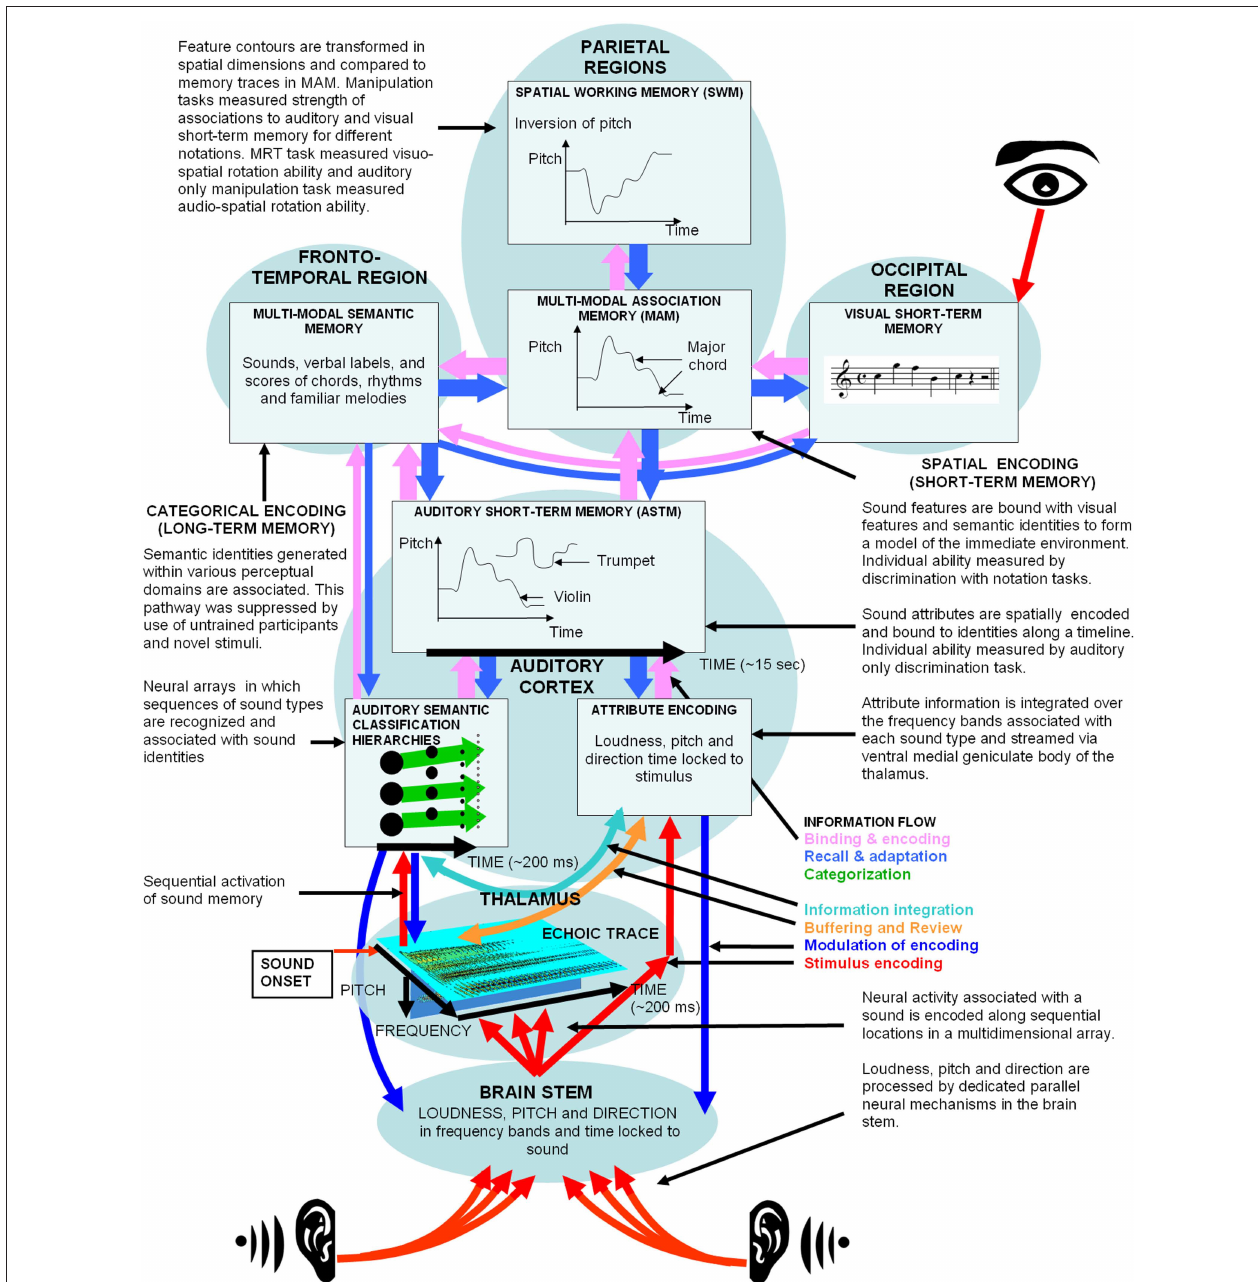
Figure 5 | The object-attribute model extended to include multimodal processing and spatial working memory. The experimental design of this study in relation to the model is outlined in the accompanying text in the